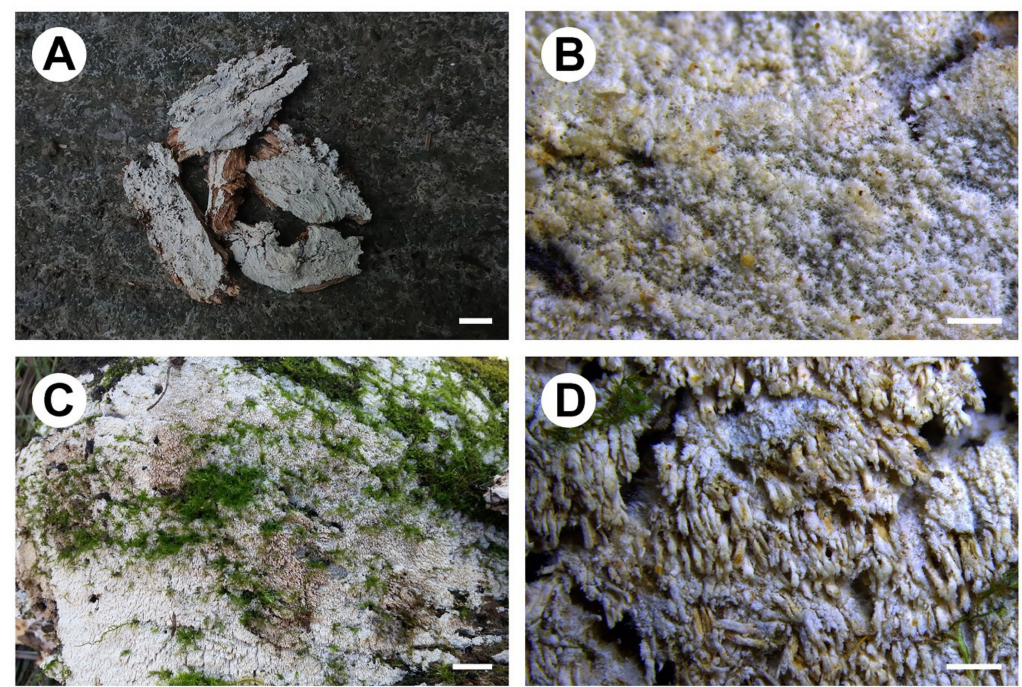
Figure 4. Basidiocarps of Fibrodontia . ( A , B ) F. austrosinensis (holotype); ( C , D ) F. subalba (holotype).—Scale bars: ( A , C ) = 1 cm; ( B ) = 0.5 mm; ( D ) = 1